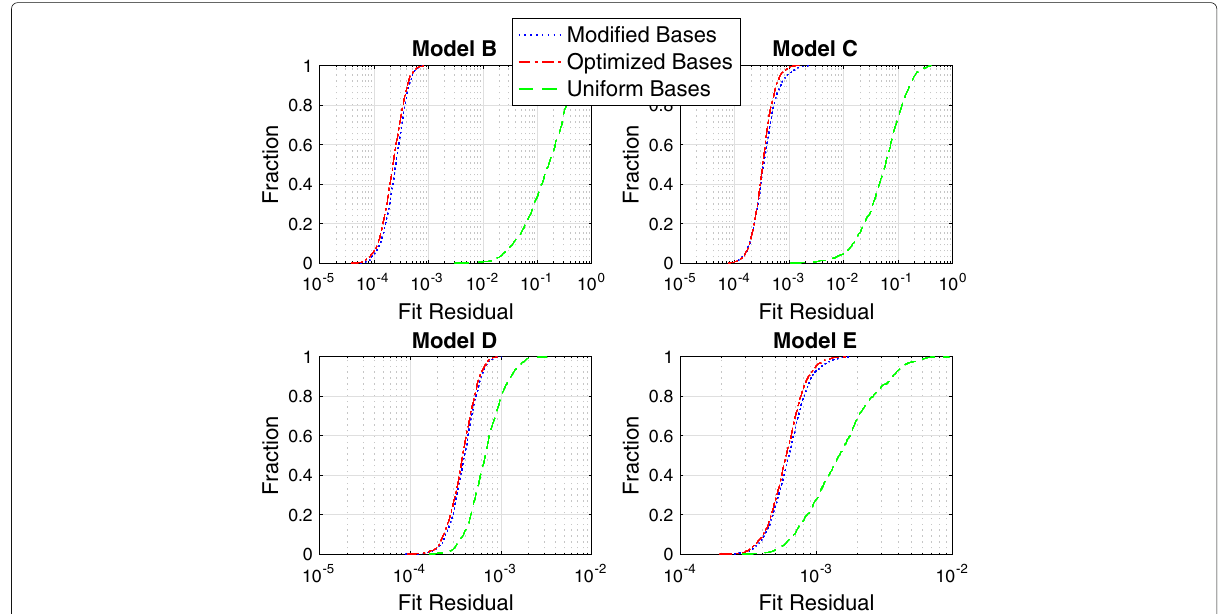
Fig. 2 Fit residual as a function of the number of base sinusoids. A comparison of the cumulative density function (CDF) of the fit residual per point is shown when running MSE Fit using optimized base sinusoids versus uniformly spaced base